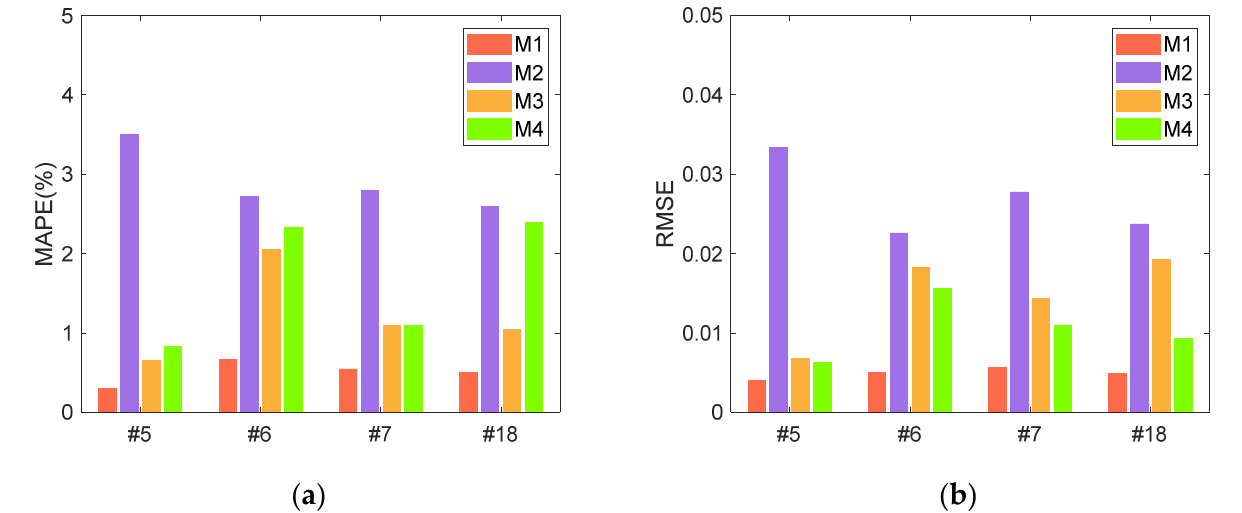
Figure 8. Prediction RMSE and MAPE on the comparisons for different models. ( a ) MAPE; ( b ) RMSE.